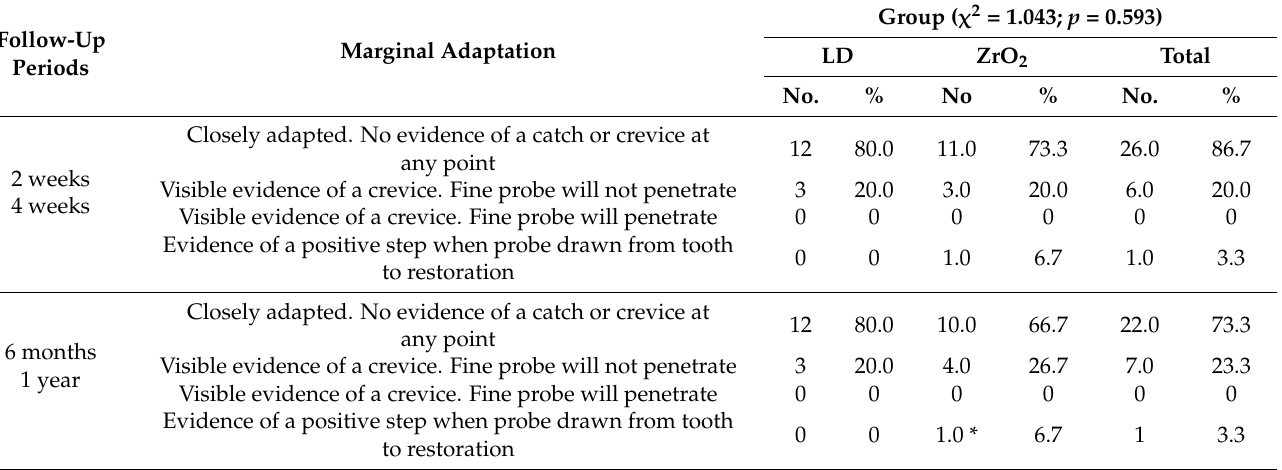
Table 7. The marginal adaptation in study groups.